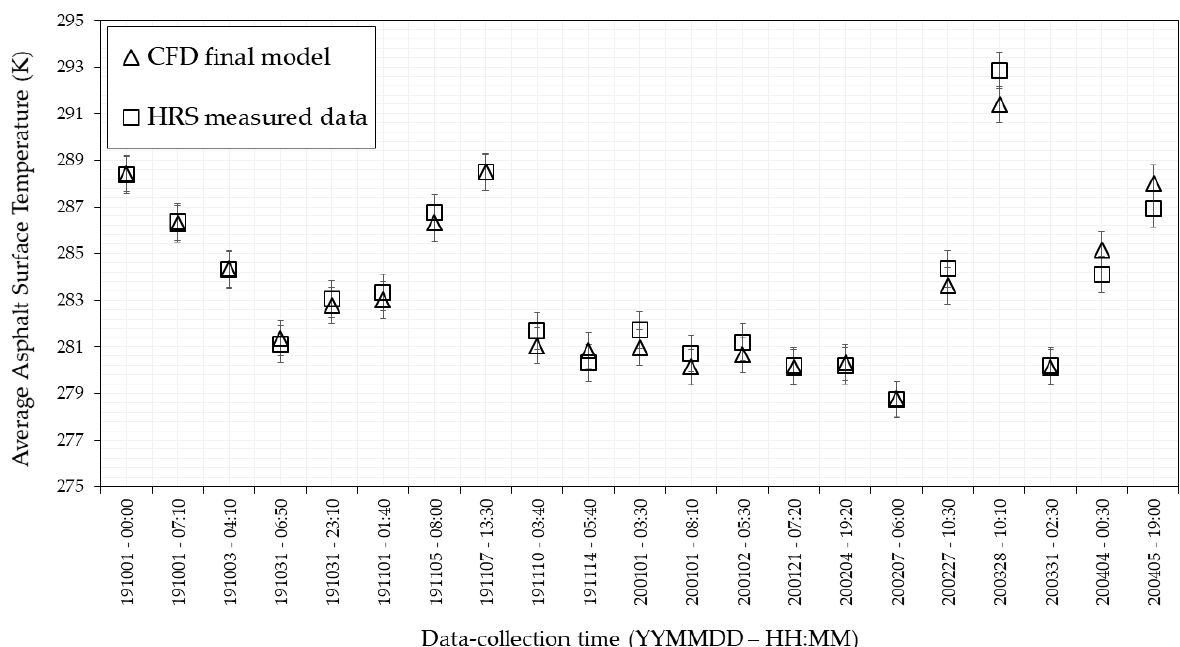
Figure 7. Comparison of asphalt surface temperatures obtained from the CFD simulation model (triangle) and from the on-site temperature sensors (square).